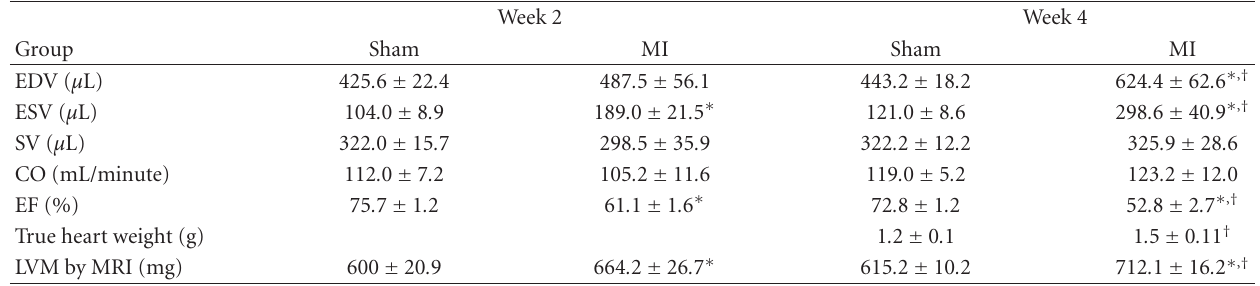
Table 1: LV global parameters.